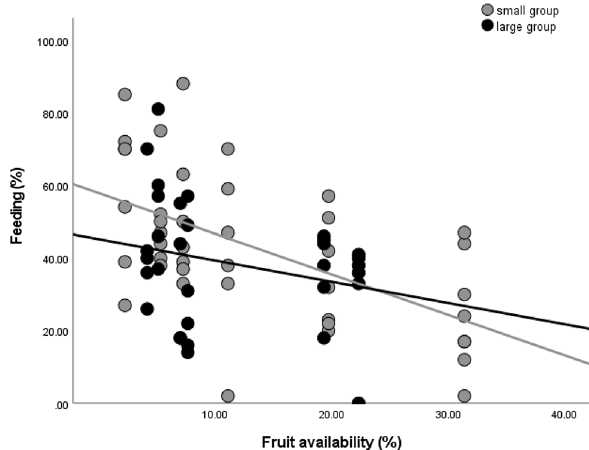
Figure 1. Group comparison for percentages of time spent feeding in relation to fruit availability. Fruit availability is measured as monthly phenological score (see “Methods”). Each dot indicates the average monthly percentage of time spent feeding for each focal individual. The lines are best-fit-lines for each group data points.